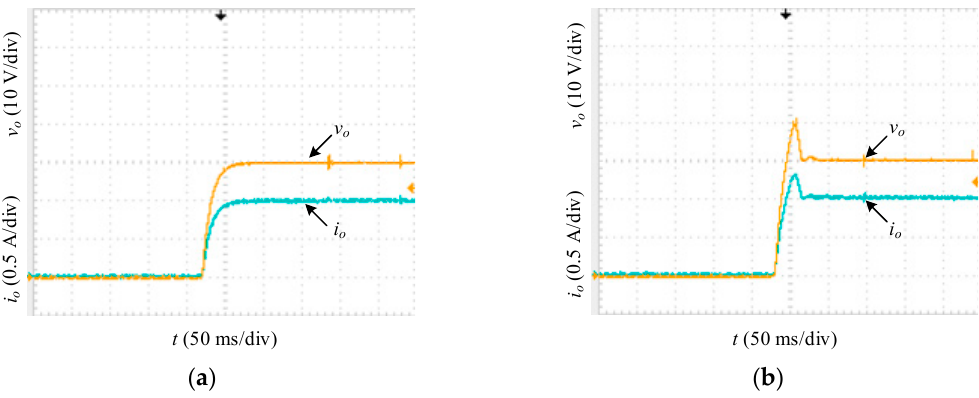
Figure 12. Startup waveforms of a buck–boost converter with a pure resistive load: ( a ) inverse-system decoupling controller; ( b ) conventional double closed-loop controller.